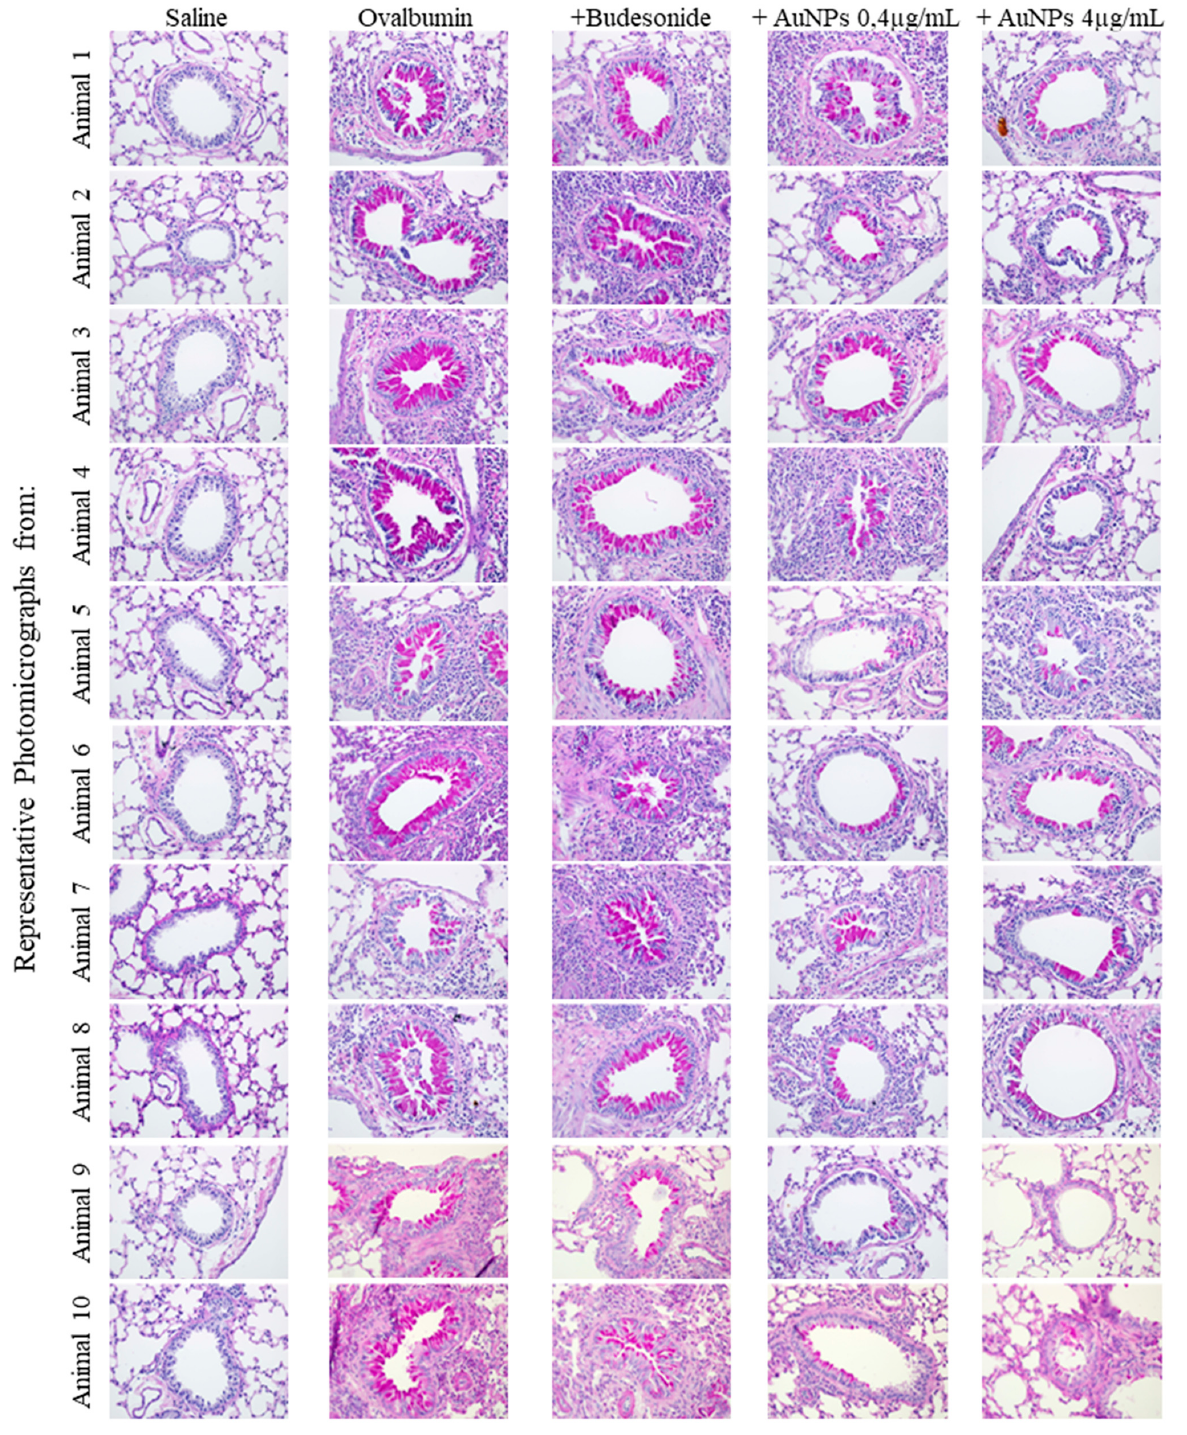
Figure A2. Effect of nebulized budesonide or AuNPs on mucus production and airway remodeling following ovalbumin intranasal instillation given once a week for 9 weeks. Photomicrographs were taken of representative airways (animals 1 to 10) stained by periodic acid-Schiff (Mucus analysis) or Gömöri trichrome (Extra cellular matrix deposit) from ovalbumin-sensitized mice challenged with saline (Saline), challenged with ovalbumin (Ovalbumin), challenged with ovalbumin and treated with budesonide (+Budesonide), challenged with ovalbumin and treated with AuNPs (+0.4 µ g/mL AuNP) and challenged with ovalbumin and treated with AuNPs (+4 µ g/mL